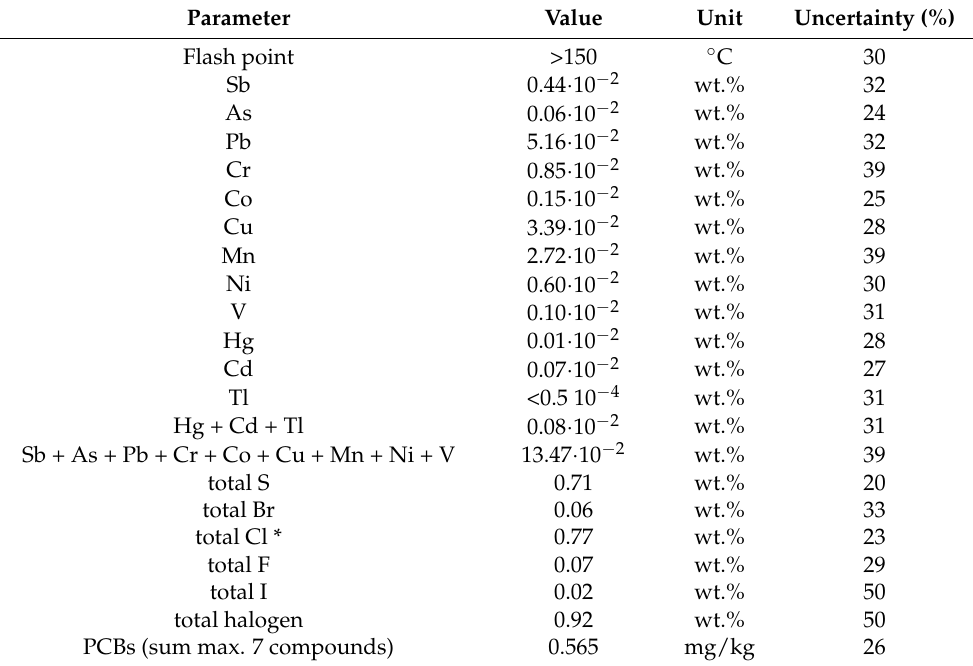
Table 2. Characterization of the SRF according to cement kiln acceptance